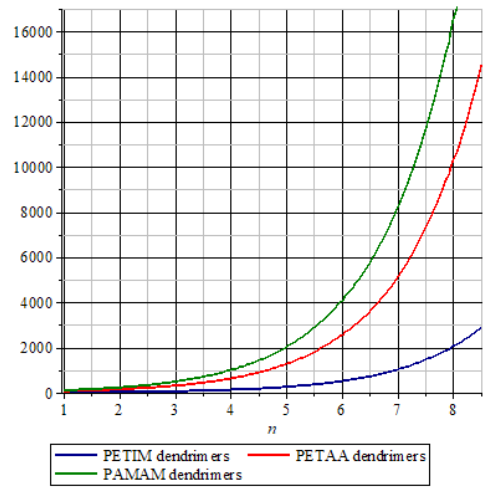
Figure 5. σ irregularity